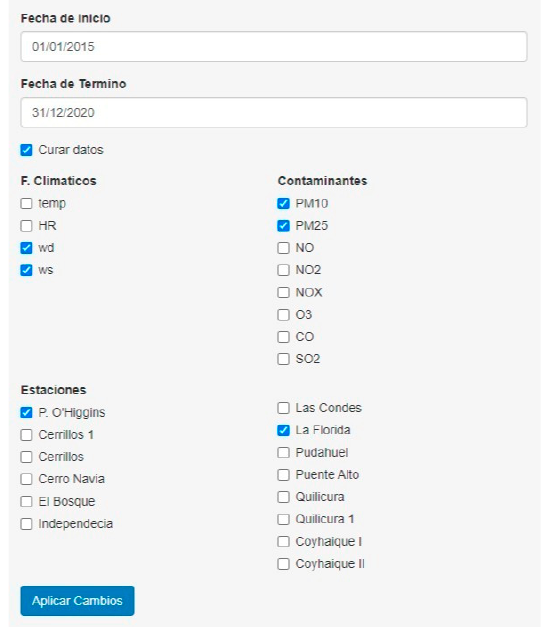
Figure A1. User interface demonstration for request the parameters “PM10”, “PM25”, “ws” (wind speed), and “wd” (wind direction) for the monitoring stations “Parque O’Higgins” and “La Florida” between 2015 and